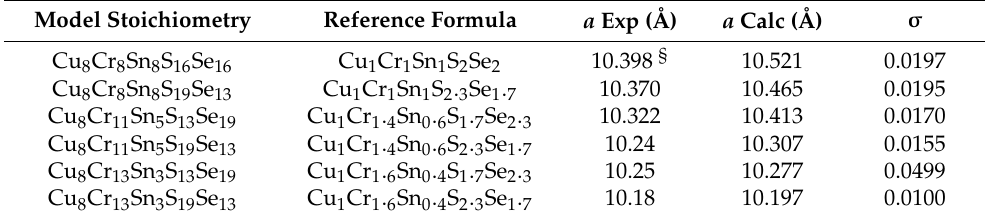
Table 4. Experimental and calculated cell parameters for different CuCr 2- x Sn x S 4- y Se y compounds. The standard deviation was calculated from three optimizations with the same stichometry but different ion